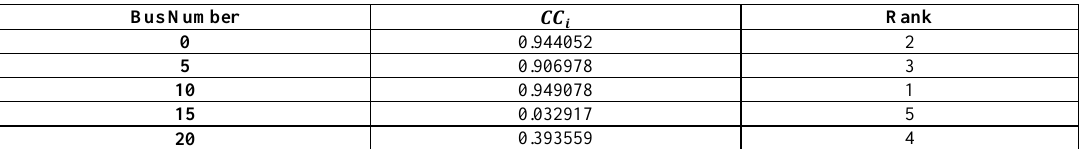
Table 15. Closeness coefficient .